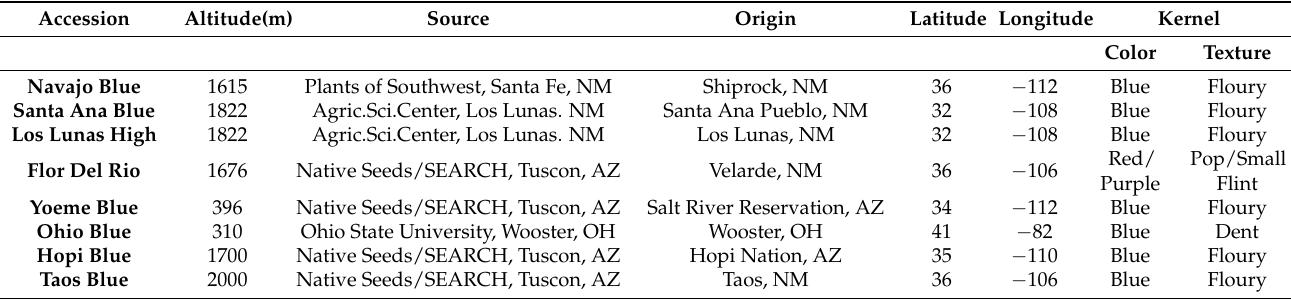
Table 7. Geographical and botanical information of eight different landraces of blue